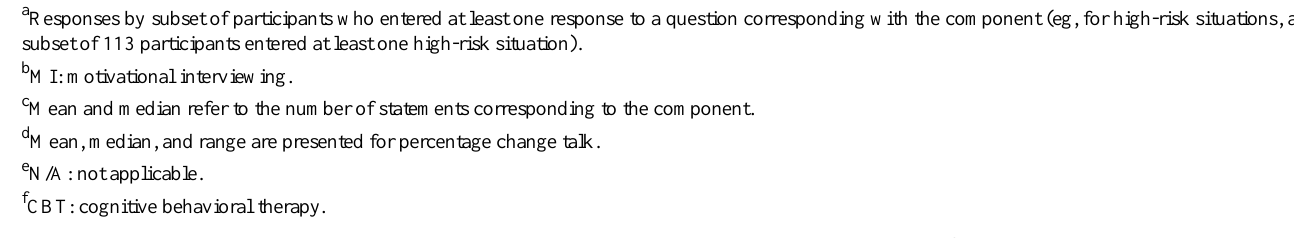
Table 2. Use of motivational interviewing and cognitive behavioral therapy components by participants in the Down Your Drink web-based alcohol intervention. MI b components (n=352,